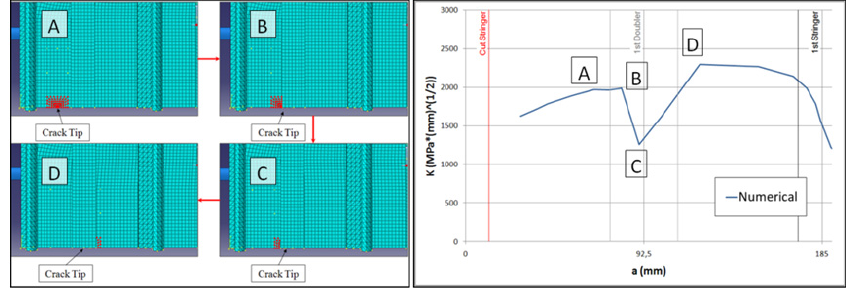
Figure 10: K value in 4 different positions of the crack tip across a doubler and a stiffener.